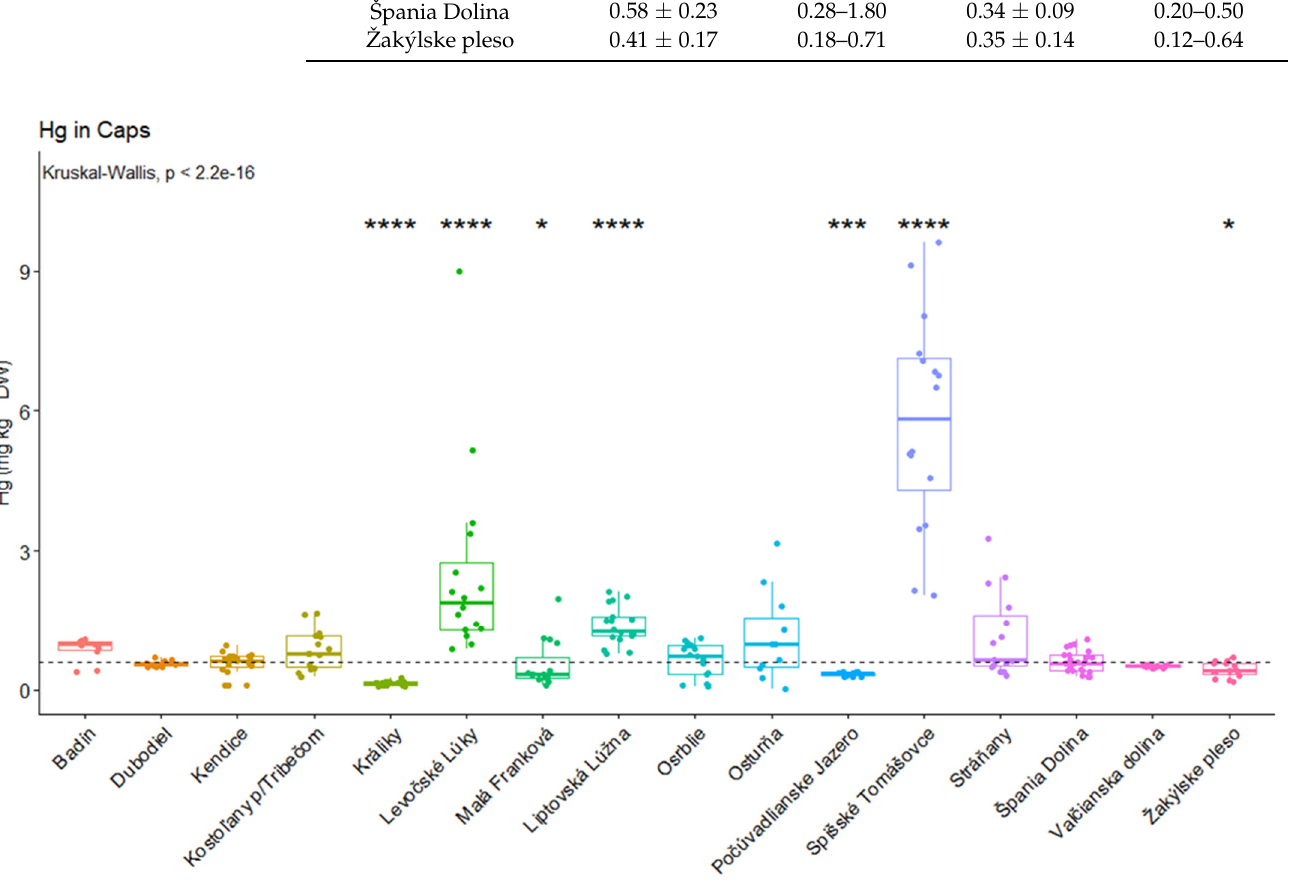
Figure 3. Significant differences in mercury concentrations (caps) in mg kg − 1 (* p < 0.05; *** p < 0.001; **** p < 0.0001).